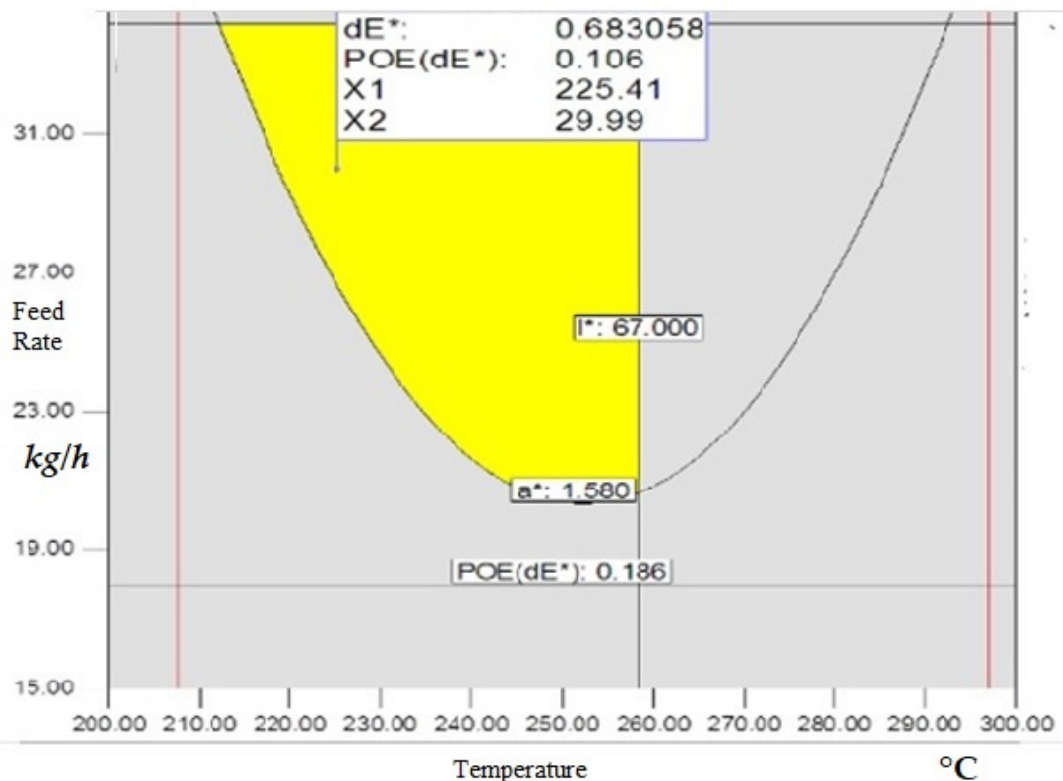
Figure 11. Interaction and overlay plot at 750 rpm.